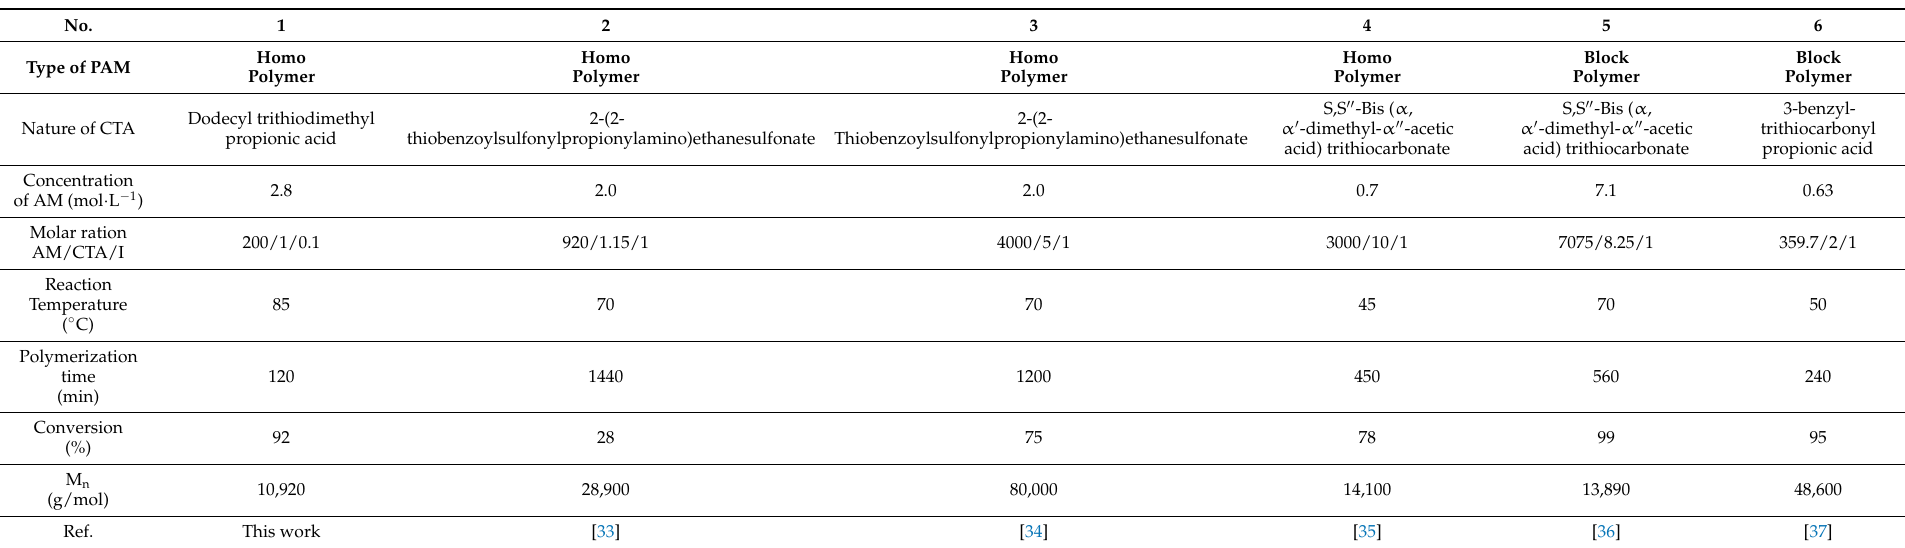
Table 2. Comparison of the results of different RAFT processes for PAM